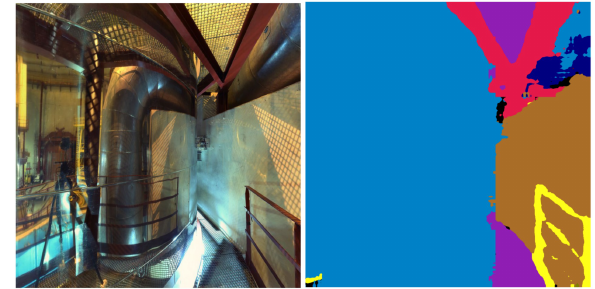
Figure 9. Confusion Matrix of stuff